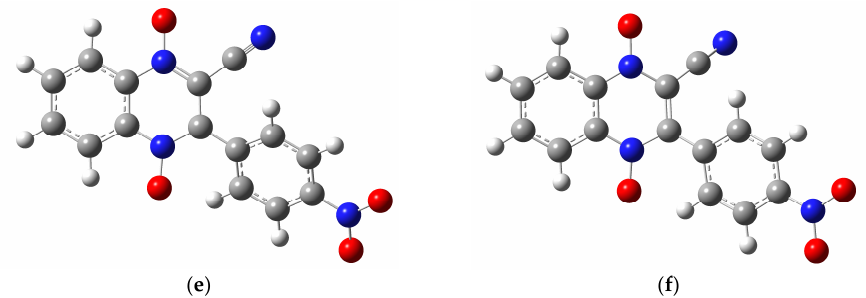
Figure A2. The individual structures for molecule E1 optimized using the 6-31g basis set: ( a ) the neutral molecule; ( b ) the possible anion product of Wave 1 with the radical on C2; ( c ) the possible anion product of Wave 1 with the radicals on C3; ( d ) the possible dianion product of the Nitro Wave with radicals on C2 and on the nitro group; ( e ) the possible dianion product of the Nitro Wave with radicals on C3 and on the nitro group; and ( f ) the trianion product of Wave 2. Chemical structures created in GaussView 5 [30] and optimized in Gaussian 09 [31].